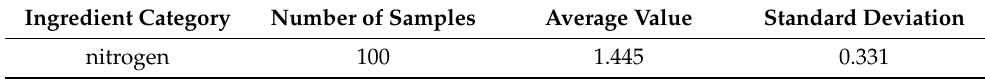
Table 4. Statistical table of component content of soil pond sample modeling set.